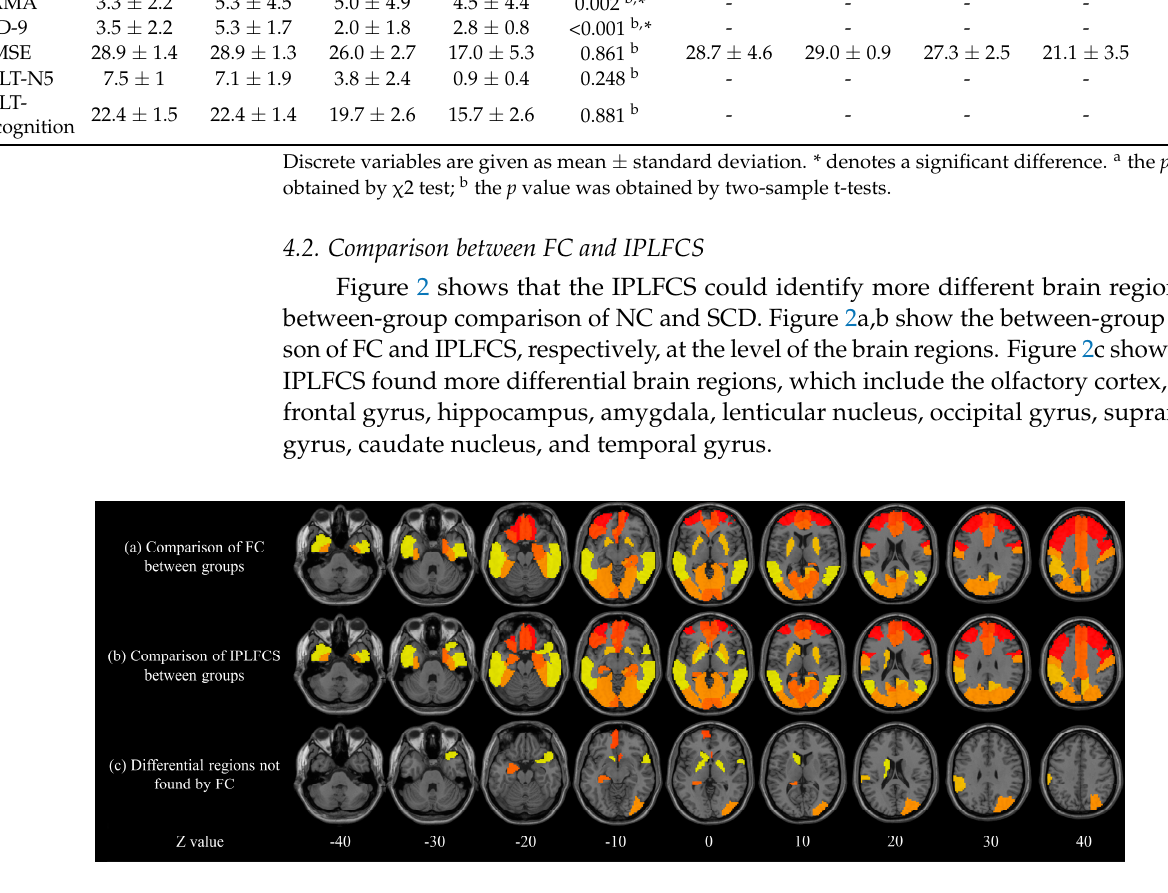
Discrete variables are given as mean ± standard deviation. * denotes a signi fi cant di ff erence. a the p value was obtained by χ 2 test; b the p value was obtained by two-sample t-tests.